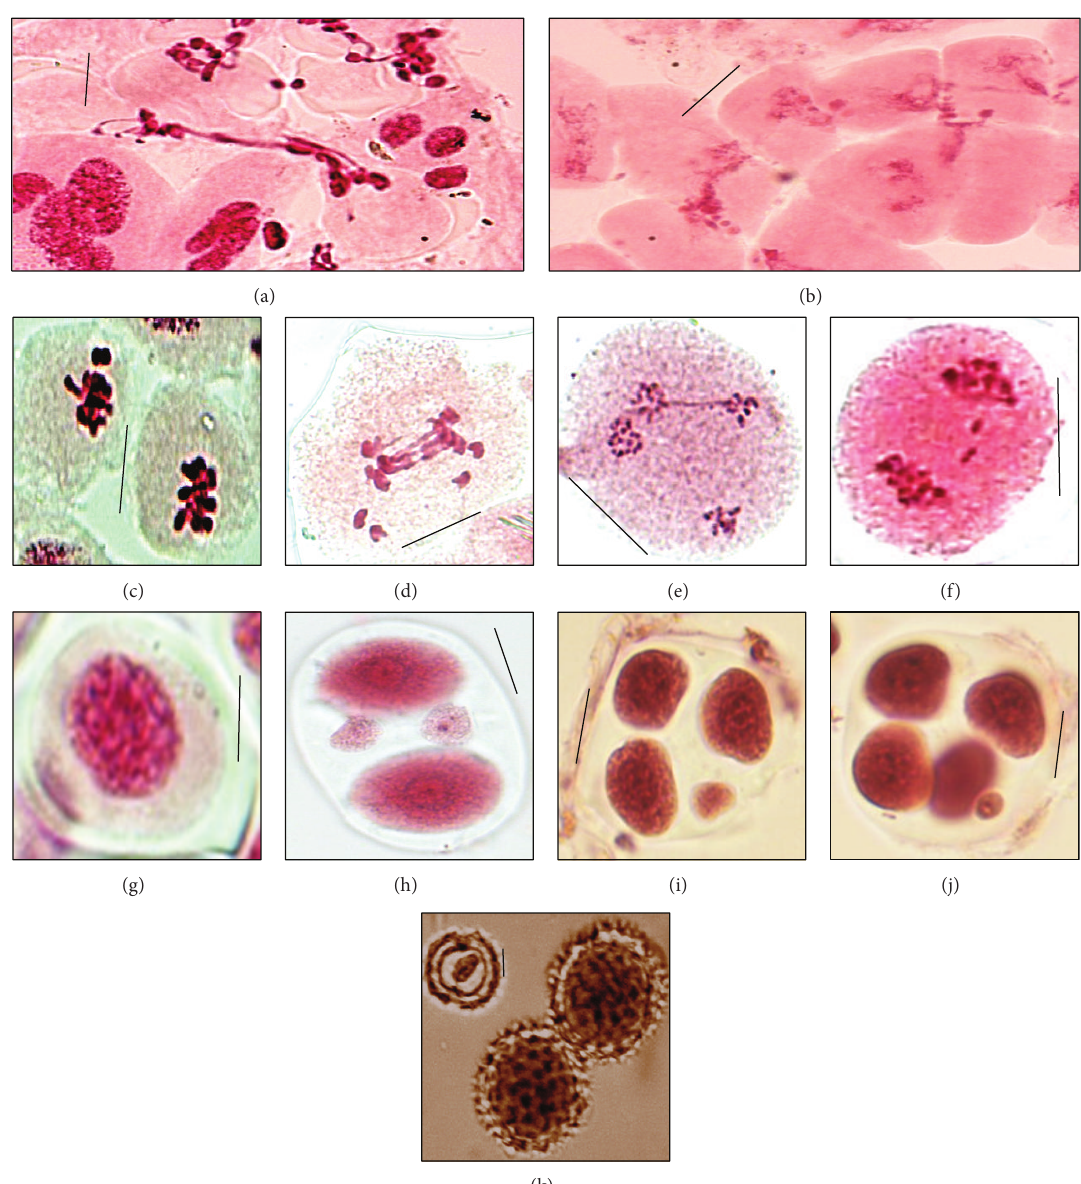
Figure 2: (a-b) PMC showing transfer of chromatin material in Taraxacum officinale and Hieracium umbellatum , respectively. (c) PMC at metaphase-I showing chromatin stickiness in tetraploid cytotype of T. officinale . (d) PMC showing late disjunction at anaphase-1 ( arrowed ). (e) PMC at telophase-II showing chromatin bridges ( arrowed ). (f) PMC at anaphase-I showing chromatin laggards ( arrowed ) in triploid cytotype of T. officinale . (g) Monad. (h) Diad with micronuclei. (i) Triad with micronucleus. (j) Tetrad with micronucleus. (k) Heterogeneous sized fertile and sterile ( arrowed ) pollen grains. (Scale: 10 𝜇 m, IV: quadrivalent, II: bivalent, I: univalent.)